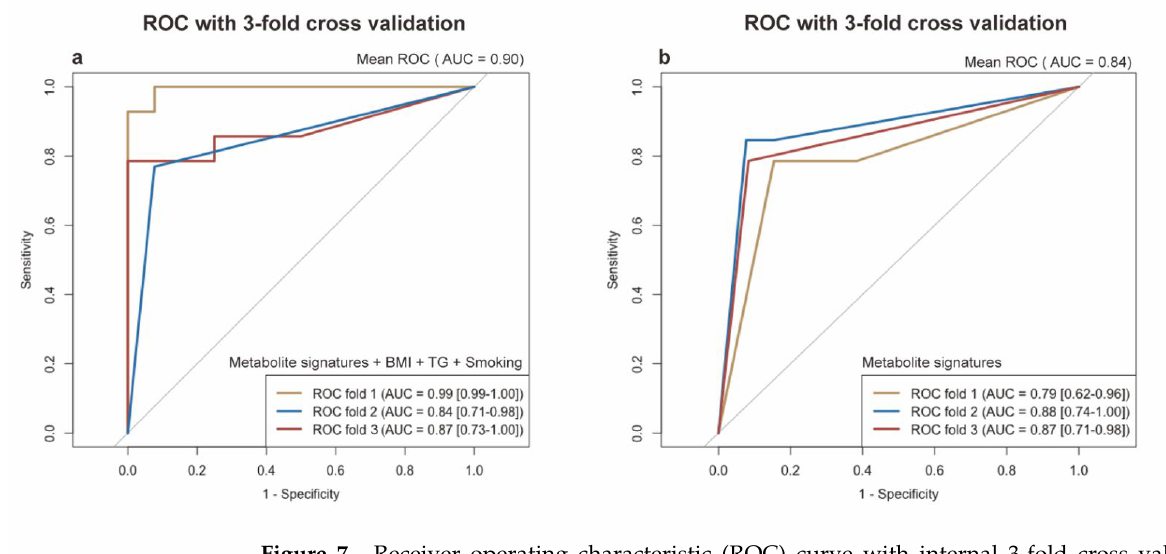
Figure 7. Receiver operating characteristic (ROC) curve with internal 3-fold cross validation. ( a ) ROC curve of logistic model based on the metabolite signatures, e.g., BMI, TG, and smoking. ( b ) ROC curve of logistic model only based on the metabolite signatures. The x-axis represents the false-positive rate. The y-axis represents the true-positive rate. The lines represent the performance of each fold. Metabolite signatures include N1-Methyl-4-pyridone-3-carboxamide, 2,6-Dimethoxy-4- (1-propenyl)phenol, Tigloidine, Artonin C, and